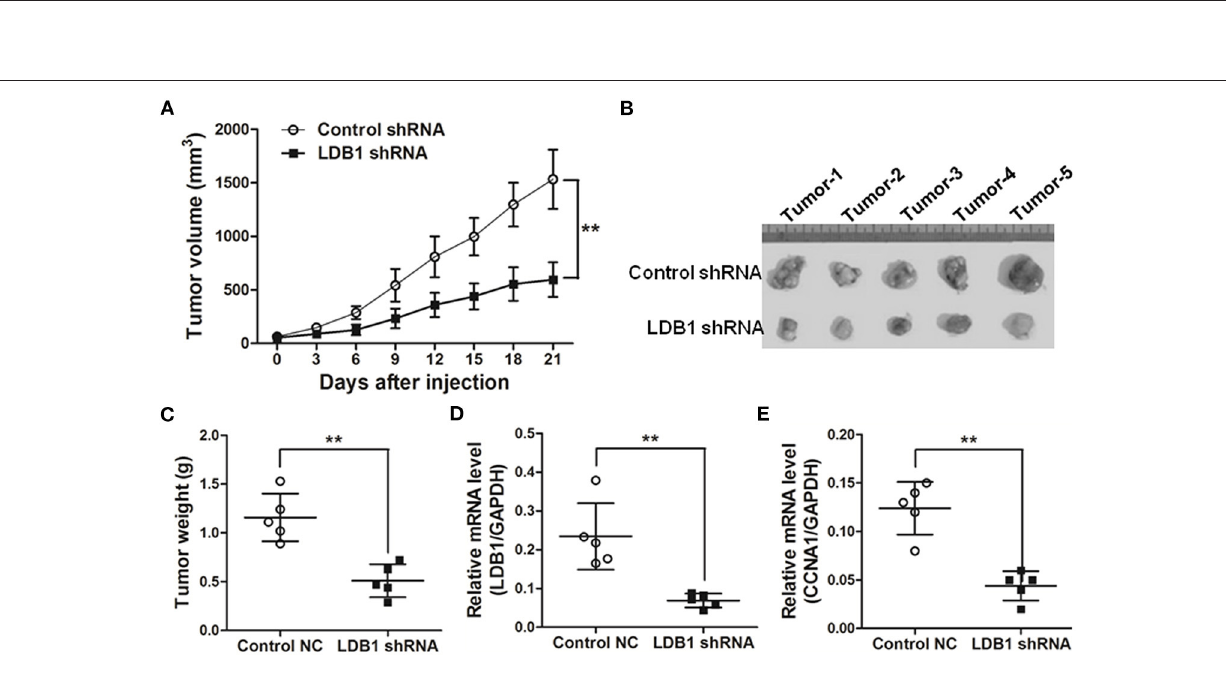
FIGURE 4 | Knockdown of LDB1 inhibits tumor growth in nude mice. (A) The tumor growth curves. (B,C) At the end of the animal study, tumors were excised and taken photos (B) . And the tumors were also weighed (C) . (D,E) . Tumors were also prepared for qRT-PCR analysis to detect LDB1 (D) and CCNA1 (E) expression. GAPDH was used as an internal control ** p <